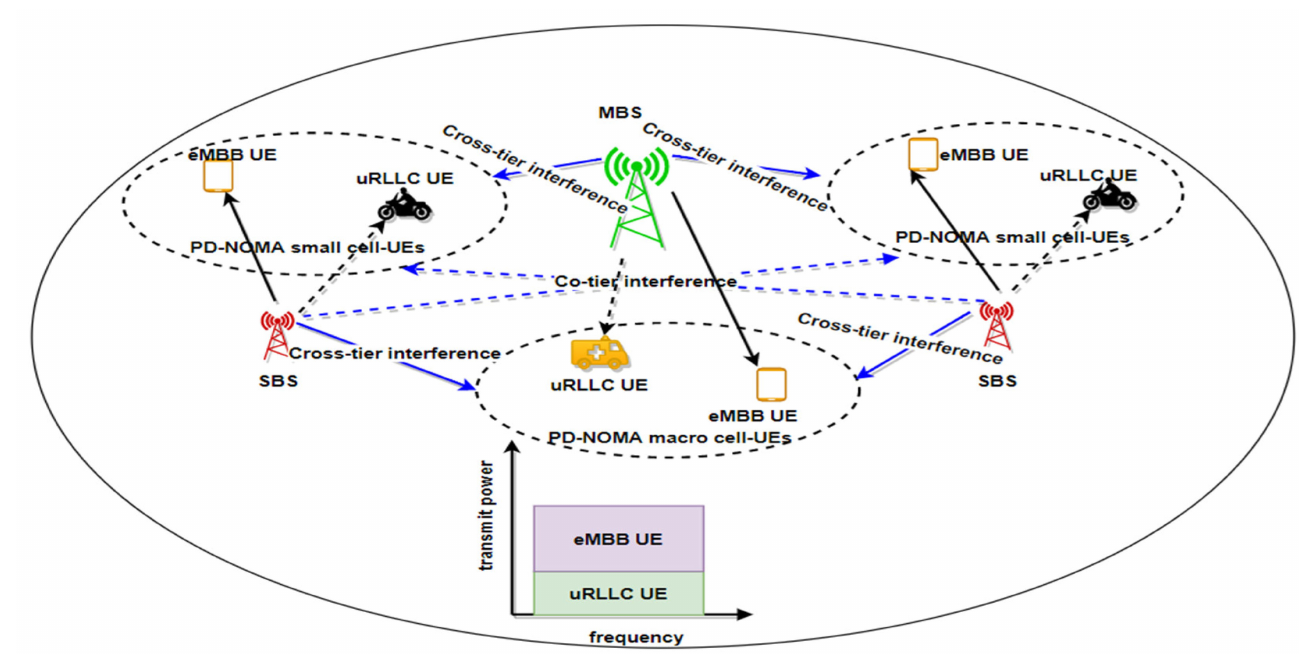
Figure 3. An illustration of eMBB and uRLLC users down-link PD-NOMA HetNet scheme. nm Under the superposition scheme, the SINR Ґ is received by the UE u ∈ U from a bu BS b ∈ B on a PRB n ∈ N s per mini slot m ∈ (cid:77) as, can be as b